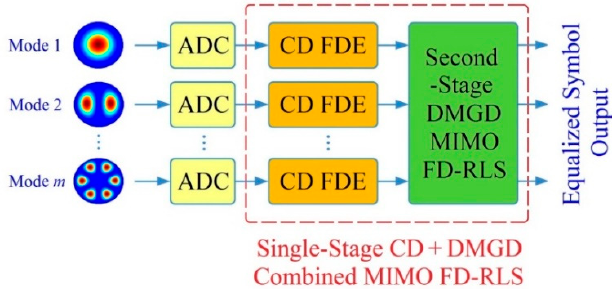
Figure 26. The representation of a coherent receiver with the joint compensation of chromatic dispersion (CD) plus differential mode group delay (DMGD) through a single-stage MIMO architecture [10].